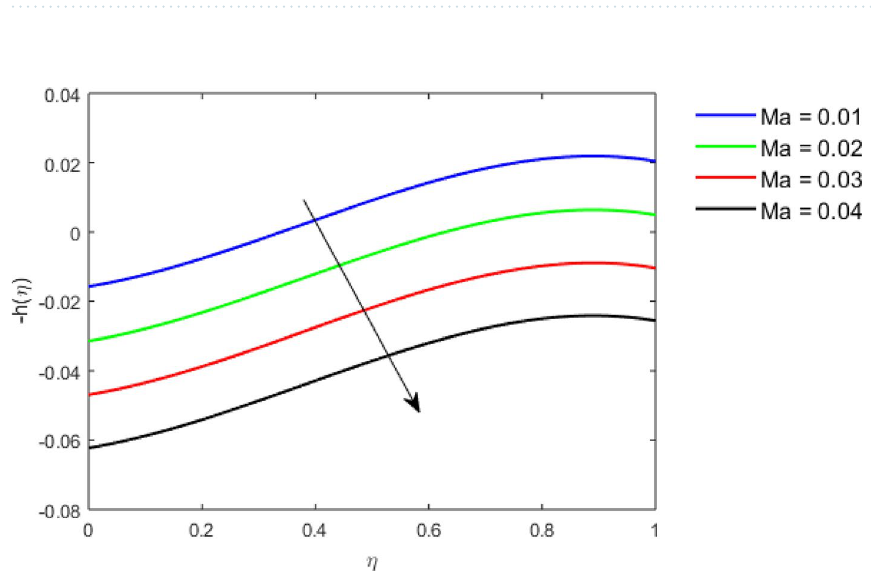
Figure 12. The Axial velocity profile for melting heat parameter Ma , for Pseudoplastic